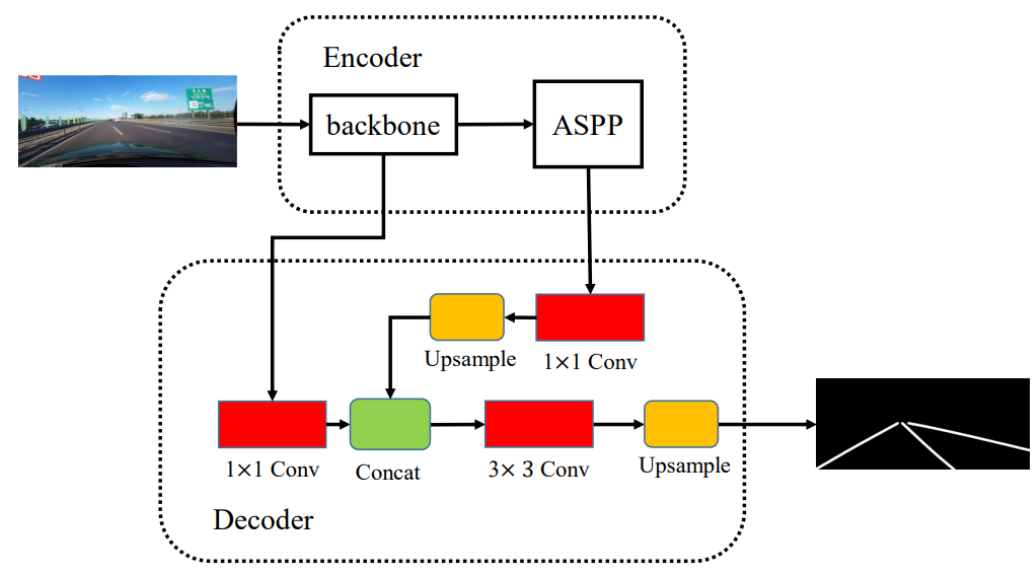
Figure 1. The original deeplabv3plus architecture.